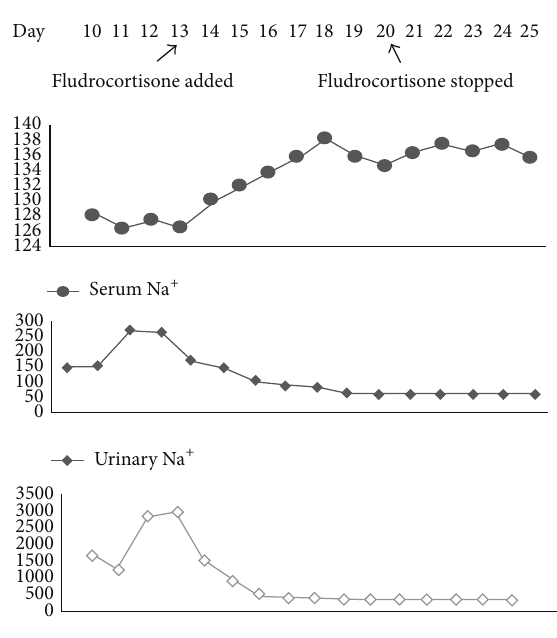
Figure 2: Relationship of urine output (mL/day), serum sodium (meq/L), and urinary sodium (meq/L) before and after treatment with